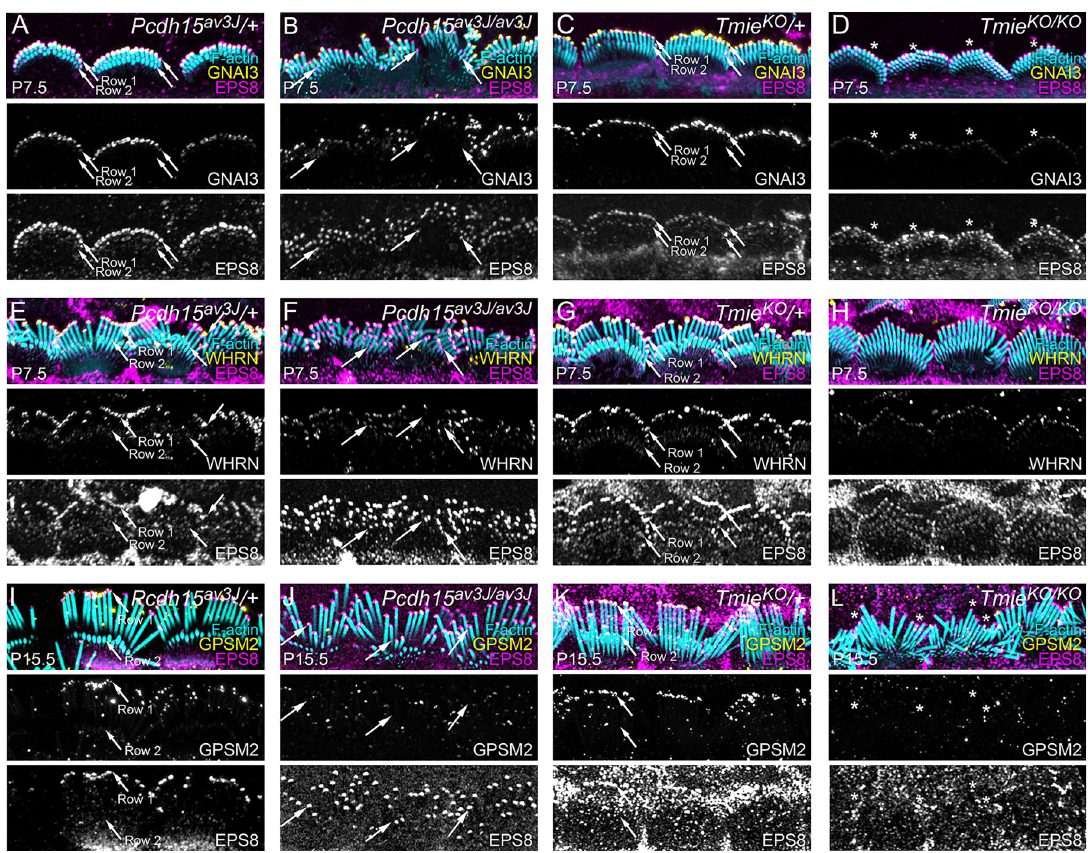
Fig 10. Row 1 protein localization in mutant IHCs. ( A–D ) Localization of GNAI3 and EPS8 in Pcdh15 av3J and Tmie KO heterozygotes and homozygotes at P7.5. ( E–H ) Localization of WHRN and EPS8 in Pcdh15 av3J and Tmie KO heterozygotes and homozygotes at P7.5. ( I–L ) Localization of GPSM2 and EPS8 in Pcdh15 av3J and Tmie KO heterozygotes and homozygotes at P15.5. Images from all pairs of heterozygote and homozygote cochleas (A and B, C and D, E and F, G and H, I and J, K and L) were acquired in the same session and used the same acquisition, processing, and display parameters. All images are projections of horizontal slices; projections that allow visualization of the entire hair bundle typically had stereocilia splayed against the apical surface, especially at P15.5, which resulted in immunofluorescence signal from stereocilia being overlaid on top of immunofluorescence signal from apical surfaces. Small arrows in A, C, G, I, and K indicate positions of rows 1 and 2. Large arrows in B, F, and J show high levels of EPS8 in row 2 stereocilia of Pcdh15 av3J/ av3J IHCs. Asterisks in D and L show reduced levels of GNAI3 and GPSM2 in Tmie KO/KO IHCs. Panel widths: 30 μ m. IHC, inner hair